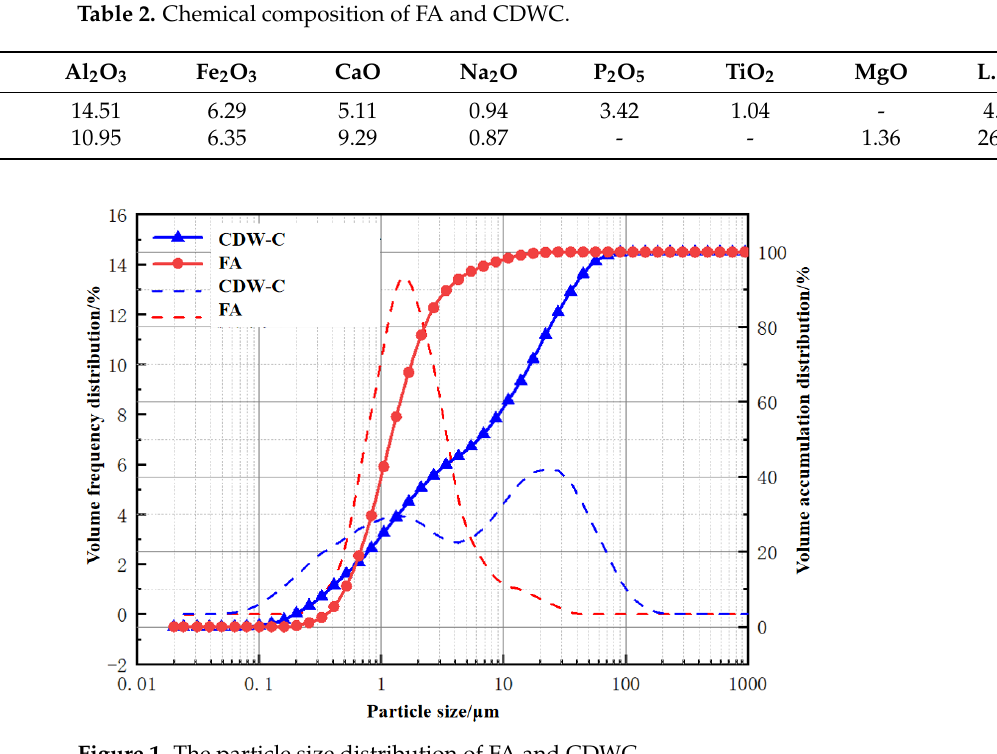
Figure 1. The particle size distribution of FA and CDWC.